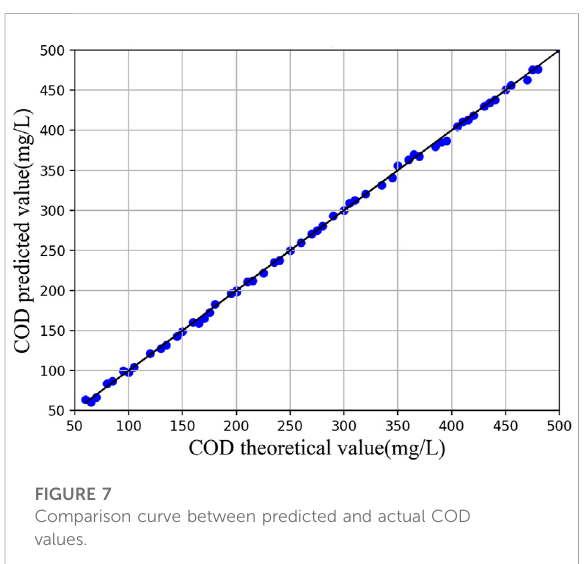
FIGURE 7 Comparison curve between predicted and actual COD values.